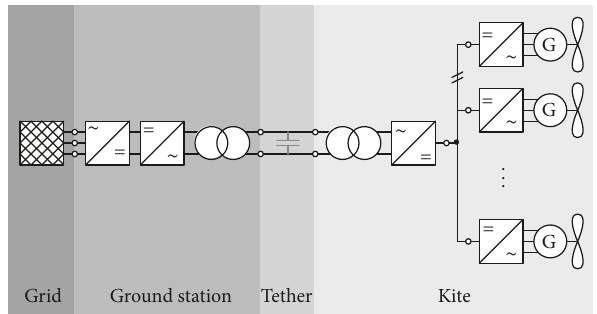
Figure 3: Power electronic topology with AC transmission, patented as “high frequency bidirectional AC power transmission”